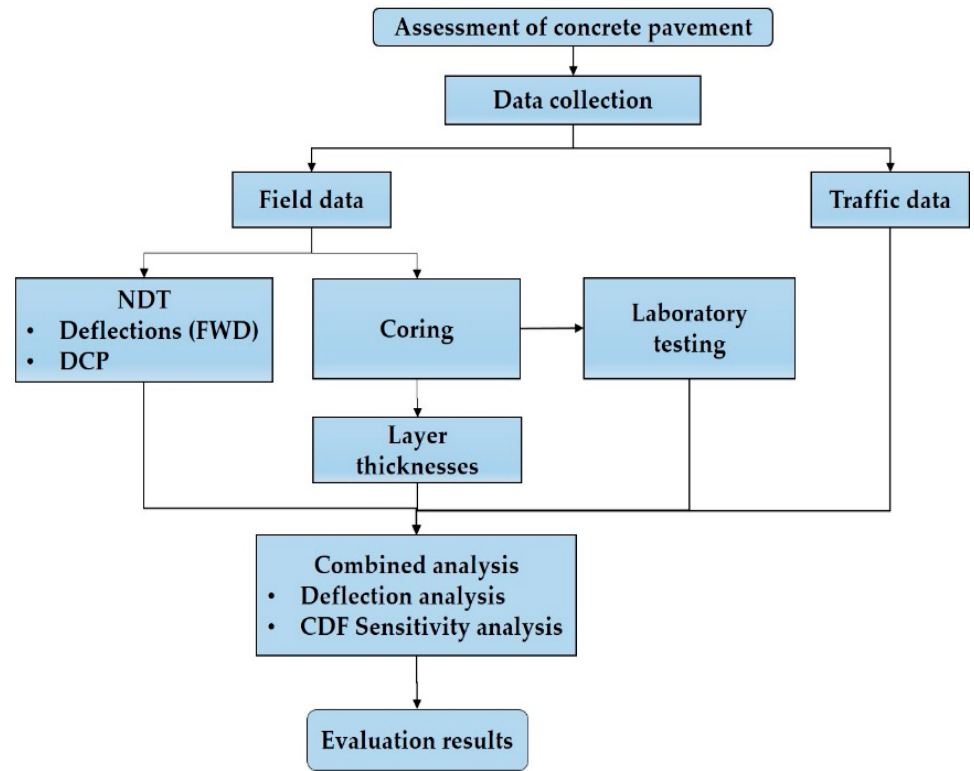
Figure 1. Methodology of this study.